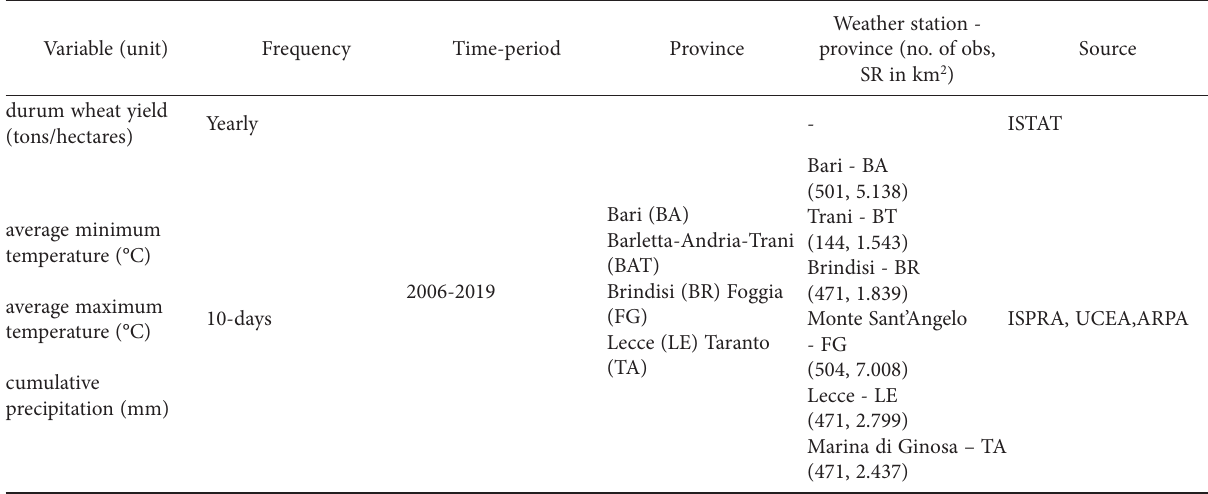
Table 2. Details on collected variables.